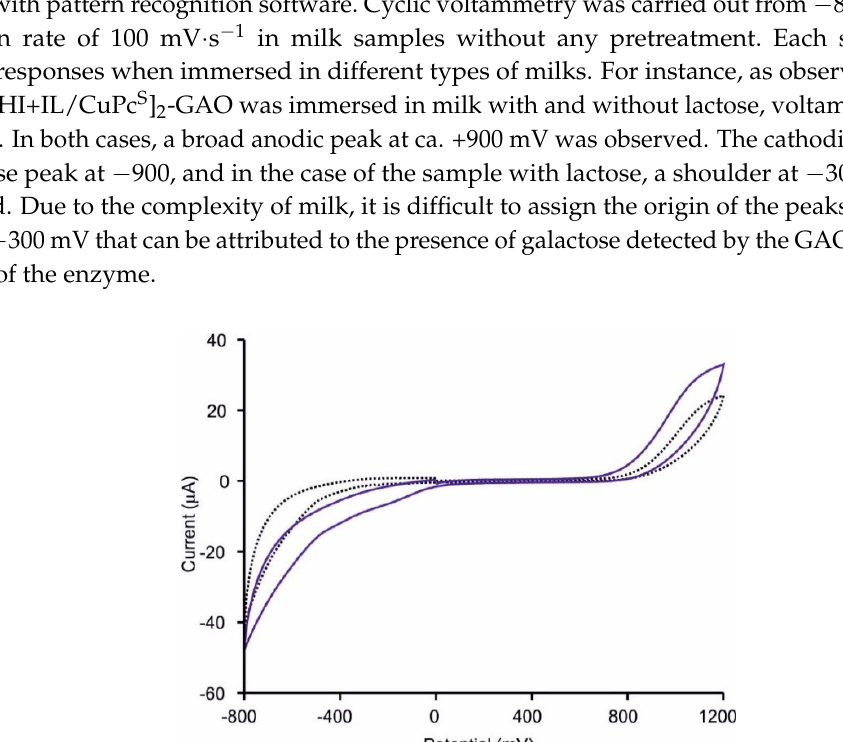
Figure 5. Cyclic voltammograms of ( a ) bare ITO (solid black line) and [CHI+IL/CuPc S ] 2 film (dashed blue line), and ( b ) ITO-GAO (solid red line) and [CHI+IL/CuPc S ] 2 -GAO (dotted black line), immersed